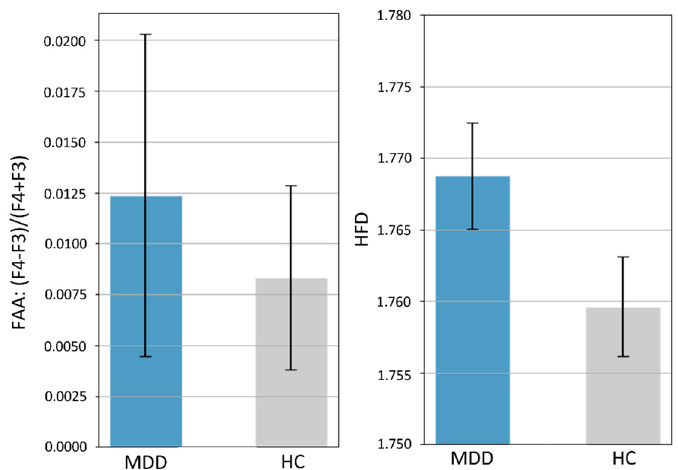
Figure 7. Means and 95% error bars (standard error of the mean) for MDD and HC participants. Left: frontal alpha asymmetry (FAA) calculated by the ratio (F4 − F3)/(F4 + F3) of alpha power. Right: EEG complexity represented by the HFD with k max = 50. There were no significant differences in FAA ( p = 0.66) and HFD-based complexity ( p = 0.07) between the MDD and HC groups.